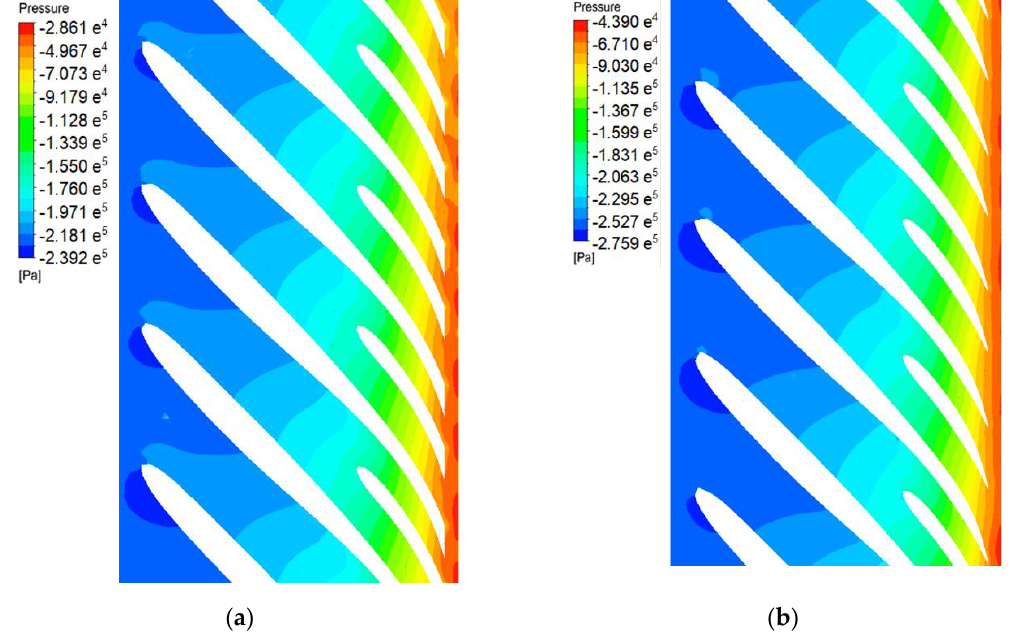
Figure 13. Comparison of static pressure contours (span = 0.5) between ( a ) the prototype; ( b ) Model C.